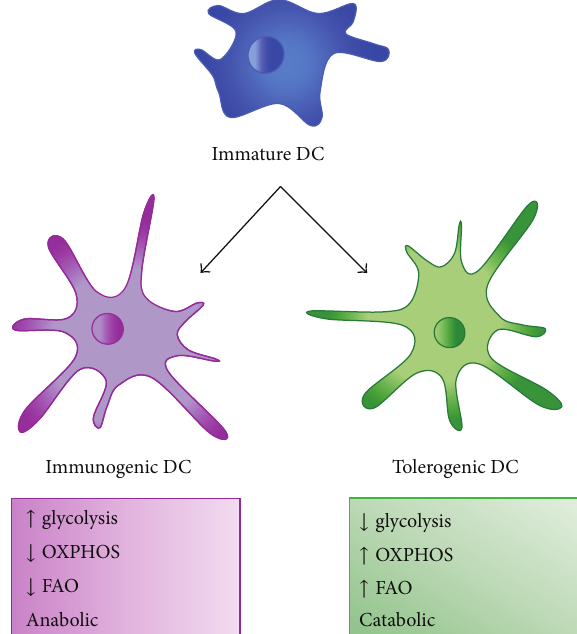
Figure 1: Differentiation of dendritic cells. Immature dendritic cells (DCs) can mature into either activated, immunogenic DCs that induce T H 1 /T H 2/T H 17 for T cell function and elimination of pathogens or tolerogenic DCs that induce the expansion of T regulatory cells and T cell unresponsiveness for immune tolerance. Immature DCs mature into immunogenic DC with a shift in metabolism towards glycolysis, which is associated with increasing biomass for effector function. Tolerogenic DC, on the other hand, shifts cellular metabolism towards OXPHOS (oxidative phospho- rylation) and favors FAO (fatty acid oxidation). This catabolic and highly energetic profile may be related to energy required for active suppression and protein